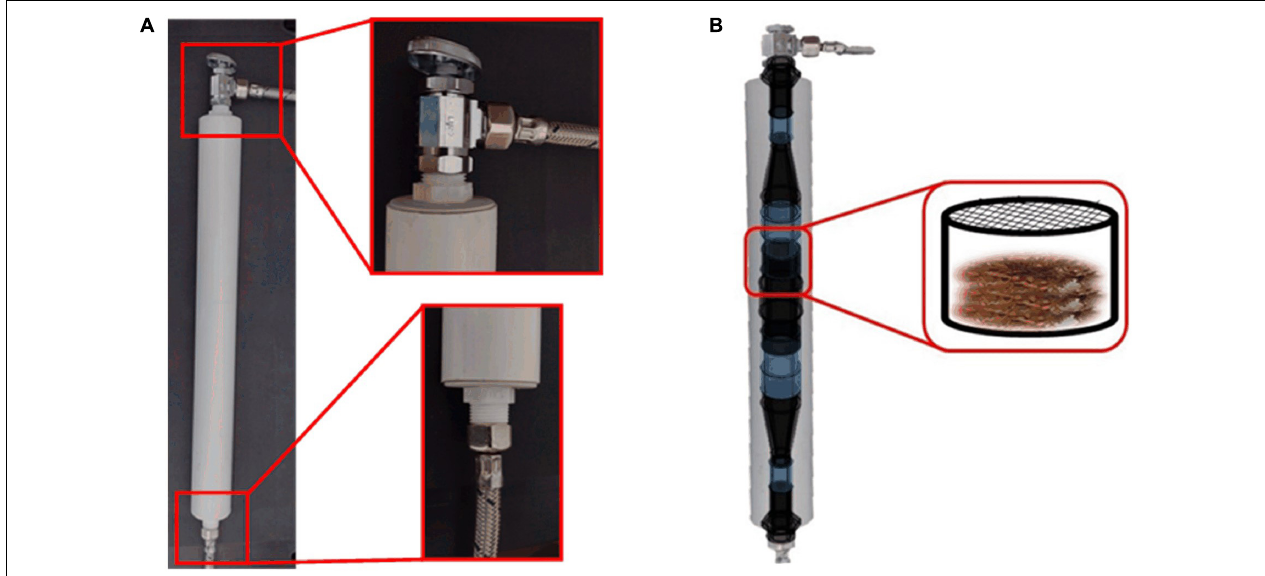
FIGURE 7 | Filter prototype for testing the removal of contaminants: (A) design of filter housing and (B) filter cartridge containing